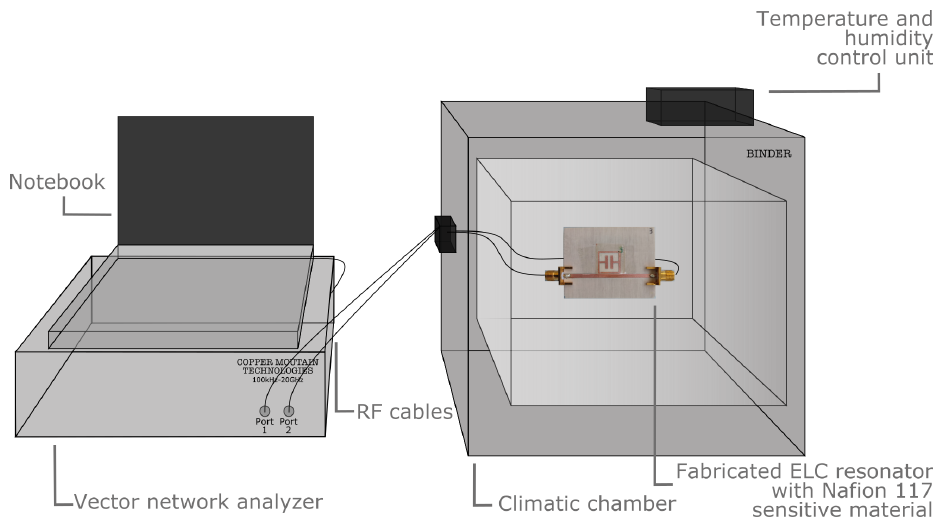
Figure 6. Schema of the setup considered for the humidity tests, with a picture of the Nafion 117-based humidity sensor realized on RO4003C substrate. The Nafion membrane is fixed with adhesive tape. | S | measurements were performed on resonators fabricated on 0.8 mm-thick DiClad, 21 RO4003C, FR4, and RO3010 using a vector network analyzer (VNA) in the range of 1–4 GHz, and a climatic chamber to vary the environmental humidity in the range of 3–33%. The | S | measurements are in agreement with the simulations and the first resonance peak as 21 well as its frequency shift and attenuation as humidity increases is reported in Figure 7. The frequency shift is much more pronounced for low relative permittivity substrates, while high permittivity substrates perform better when humidity increases and the sensitivity is quantified in peak attenuation.